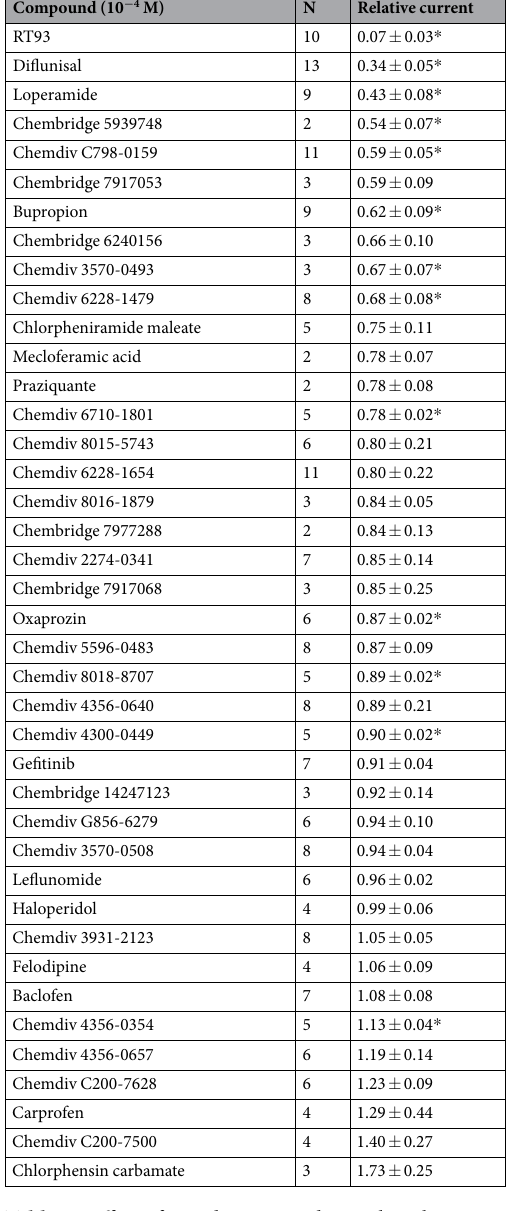
Table 3. Effect of tested compounds on ClC-Kb currents (expressed as the ratio of the current in presence of the compound over the current in the control). * Statistically different from control, p <